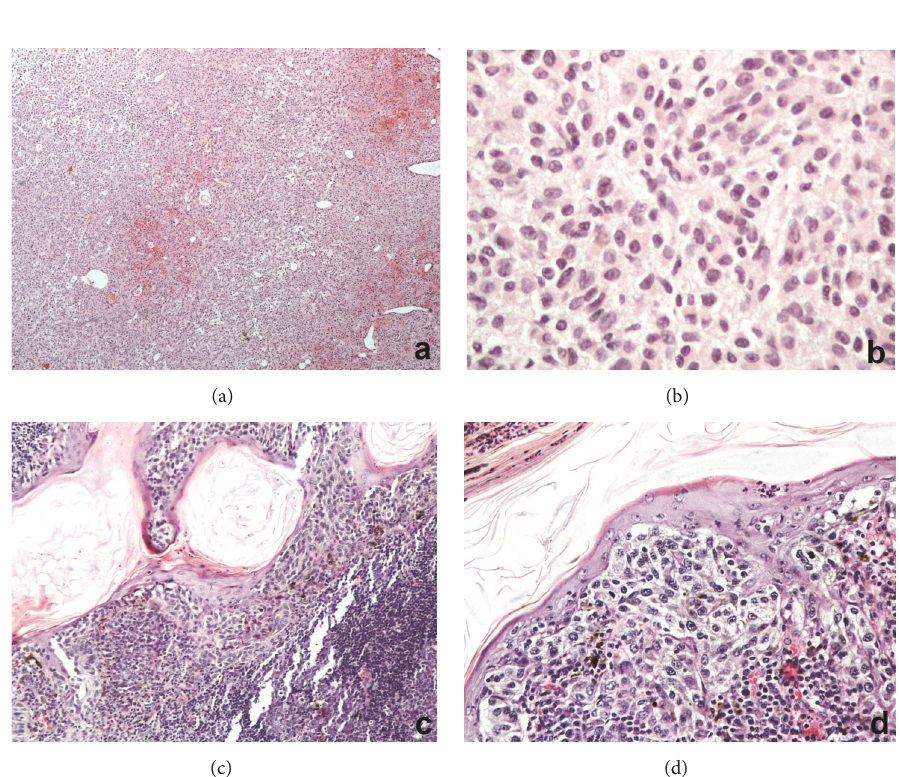
Figure 1: Histopathologic features of the urinary bladder tumor (a, b) and the cutaneous lesion (c,